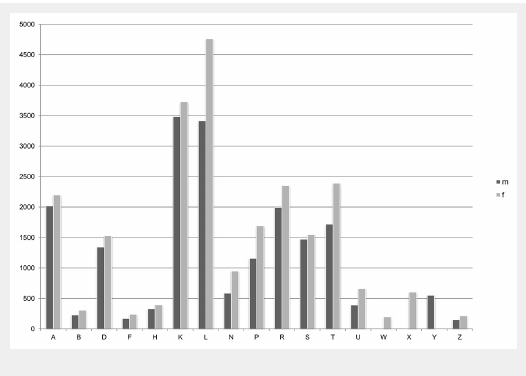
Frequency of RFE in male and female patients. Frequency of reasons for encounter (RFE) according to ICPC-2 chapters in male (dark) and female (light) patients. (A General and unspecified; B Blood, blood forming organs, lymphatics, spleen; D Digestive; F Eye; H Ear; K Circulatory; L Musculoskeletal; N Neurological; P Psychological; R Respiratory; S Skin; T Endocrine, metabolic and nutritional; U Urology; W Pregnancy, childbirth, family planning; X Female genital system and breast; Y Male genital system; Z Social